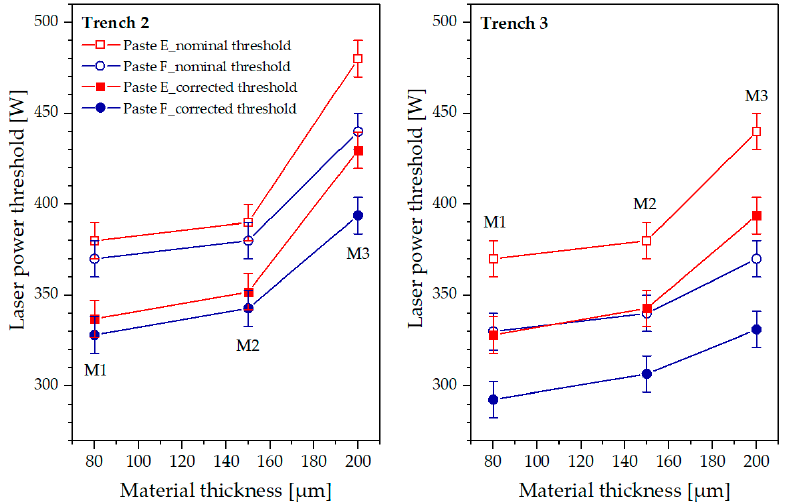
Figure 7. Comparison of nominal and corrected laser power threshold of pastes E and F for trench 2 (left) and trench 3 (right).